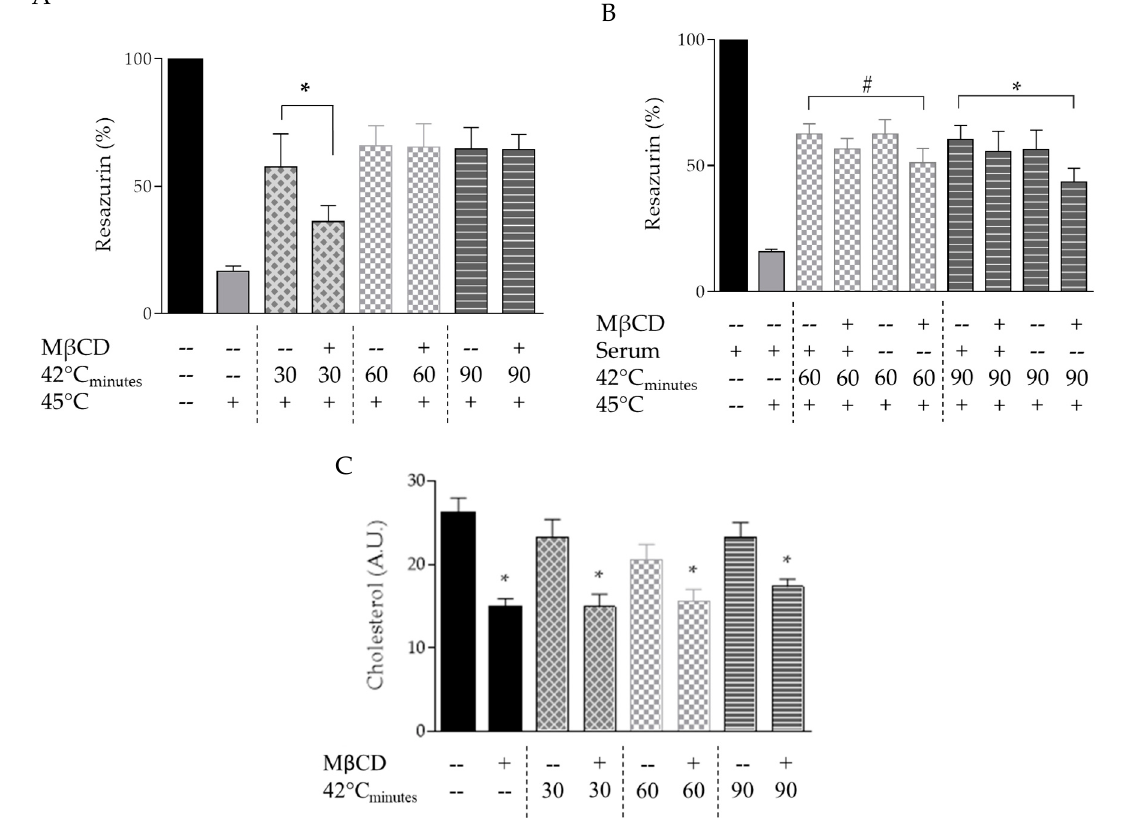
Figure 2. Effect of M β CD-induced PM modulation on development of acquired thermotolerance (ATT) in B16-F10 cells. ( A ) B16-F10 cells were exposed for 10 min to 10 mM M β CD at 37 °C followed by 30, 60, or 90 min of heat stress at 42 °C (pre-exposure). Then, after 16–18 h recovery at 37 °C, cells were re-exposed to heat stress for 30 min at 45 °C. The following day, the fraction of surviving cells was estimated with resazurin ( n = 4, * p < 0,05); ( B ) B16-F10 cells were incubated for 10 min with 10 mM M β CD at 37 °C followed by 60 or 90 min heat shock at 42 °C in serum-supplemented- or serum-free RPMI medium (limiting cholesterol supply). After pre-exposure heat stress, serum-free medium was exchanged for complete medium and cells were allowed to recover for 16–18 h at 37 °C. Then,